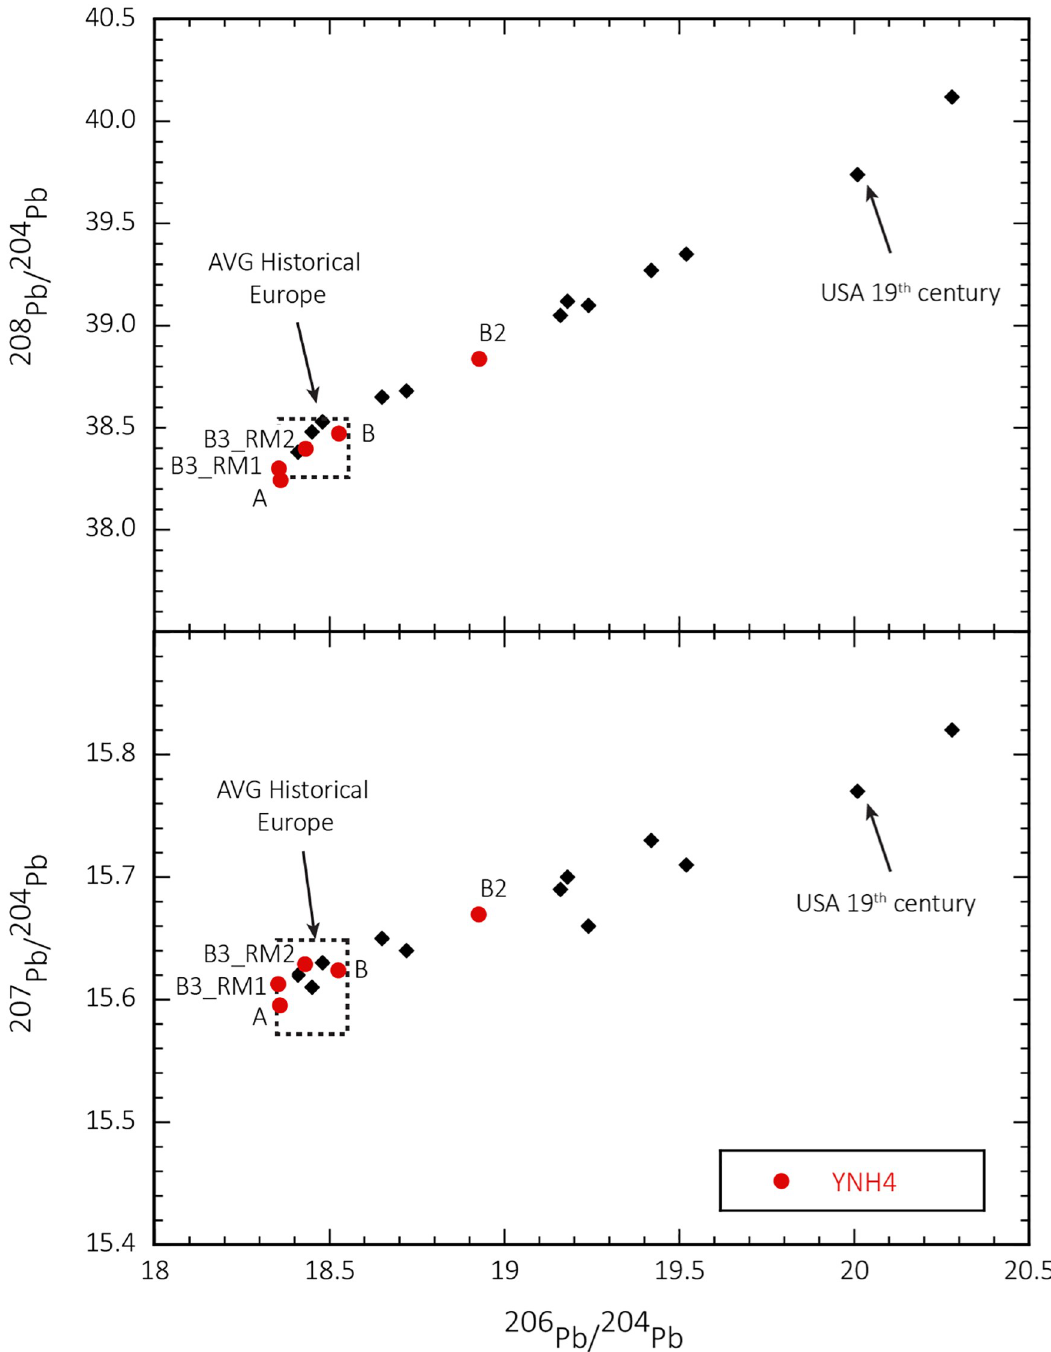
Fig 20. Lead isotope comparison between YNH4 individuals and average historical Europe and 19th century USA lead patterns. Note that all samples with exception of B2 plot within the average Europe field, consistent with inferred European origin of these individuals. B2 plots outside the European field. See text for details. Figure modified from Kamenov and Gulson [131].